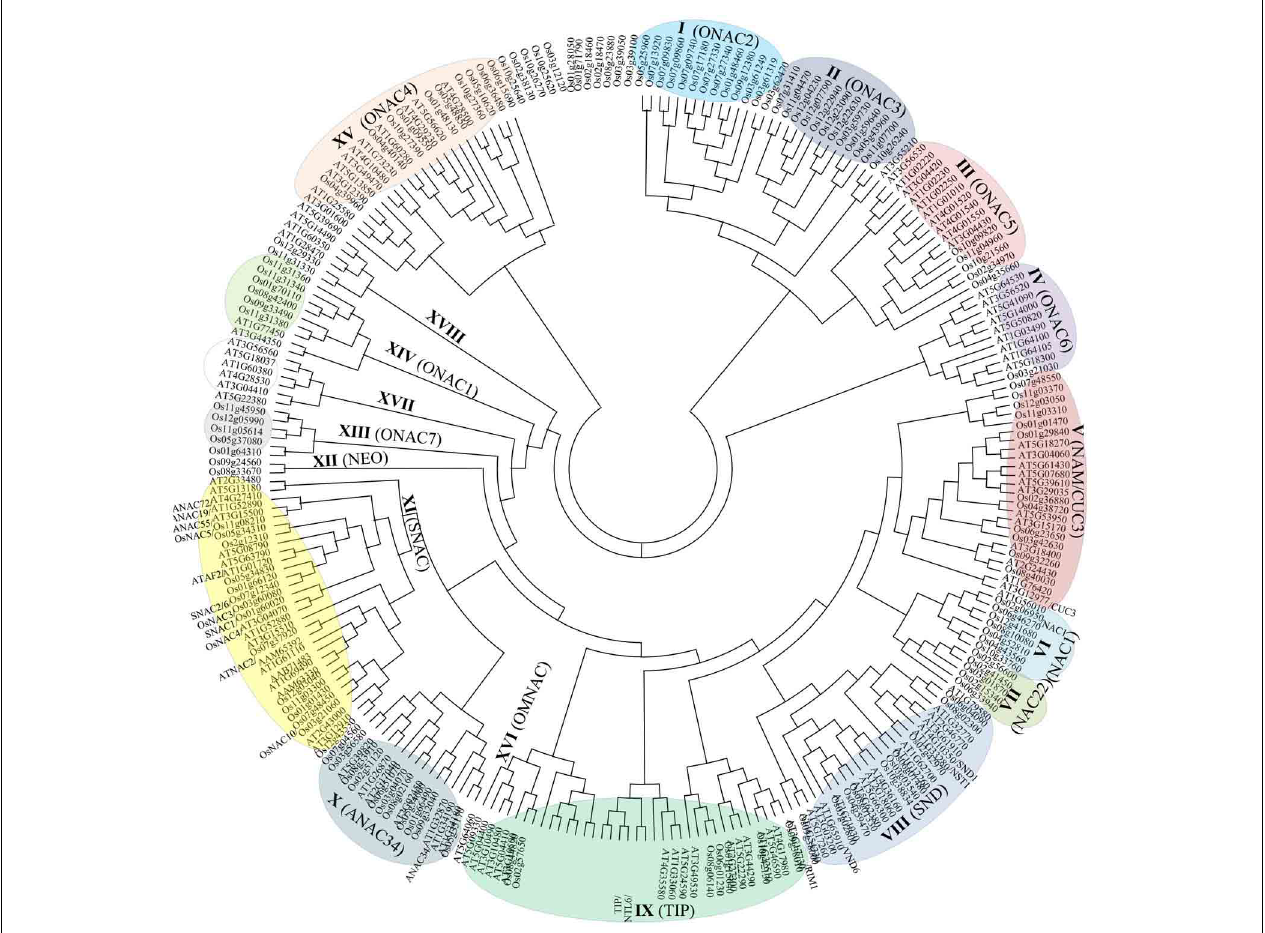
FIGURE 1 | An unrooted phylogenetic tree of the NAC transcription factors of rice and Arabidopsis. The amino acid sequences of the NAC domain of 135 rice NAC family proteins and 117 Arabidopsis NAC proteins were aligned by ClustalW, and the phylogenetic tree